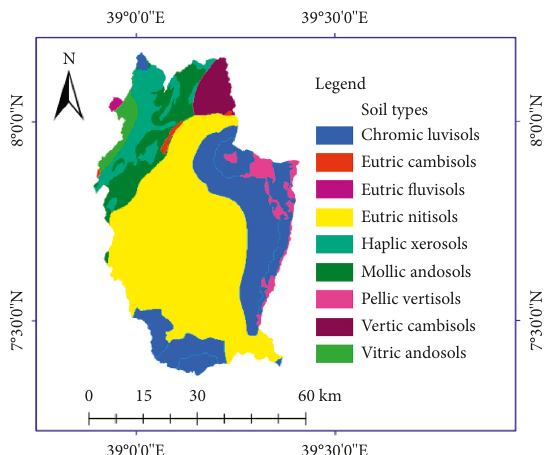
Figure 2: Soil types of the Ketar River watershed.